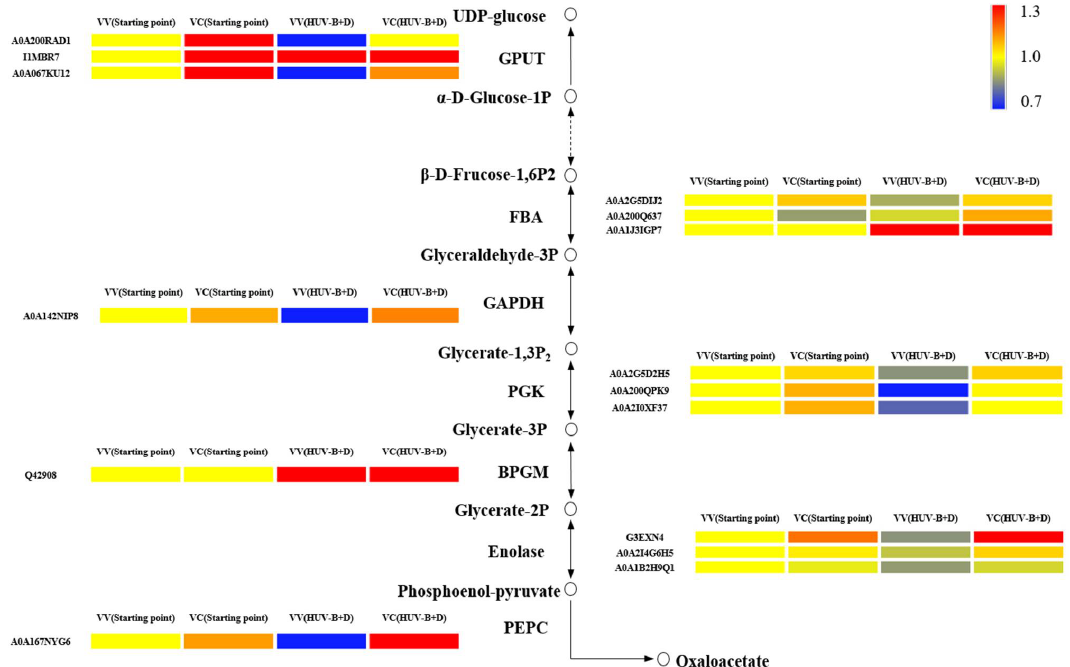
Figure 5. Expression profile analysis of glycolysis-associated proteins. Each square and color indicates the fold-change for a differentially expressed protein. Blue and red indicate a decrease and increase, respectively, in fold-change compared with the corresponding group: VV(SP) proteins in VIGS-vector plants at starting point, VC(SP) proteins in VIGS-CtPPO plants at starting point, VV(HUV-B+D) proteins in VIGS-vector plants after HUV-B+D treatment, and VC(HUV-B+D) proteins in VIGS-CtPPO plants after HUV-B+D treatment. FBA: fructose-1,6-bisphosphate aldolase; GAPDH: glyceraldehyde-3-phosphate dehydrogenase; PEPC: phosphoenolpyruvate carboxylase; circle: metabolite; arrow: direction; solid line: single step; dotted line: multiple step.